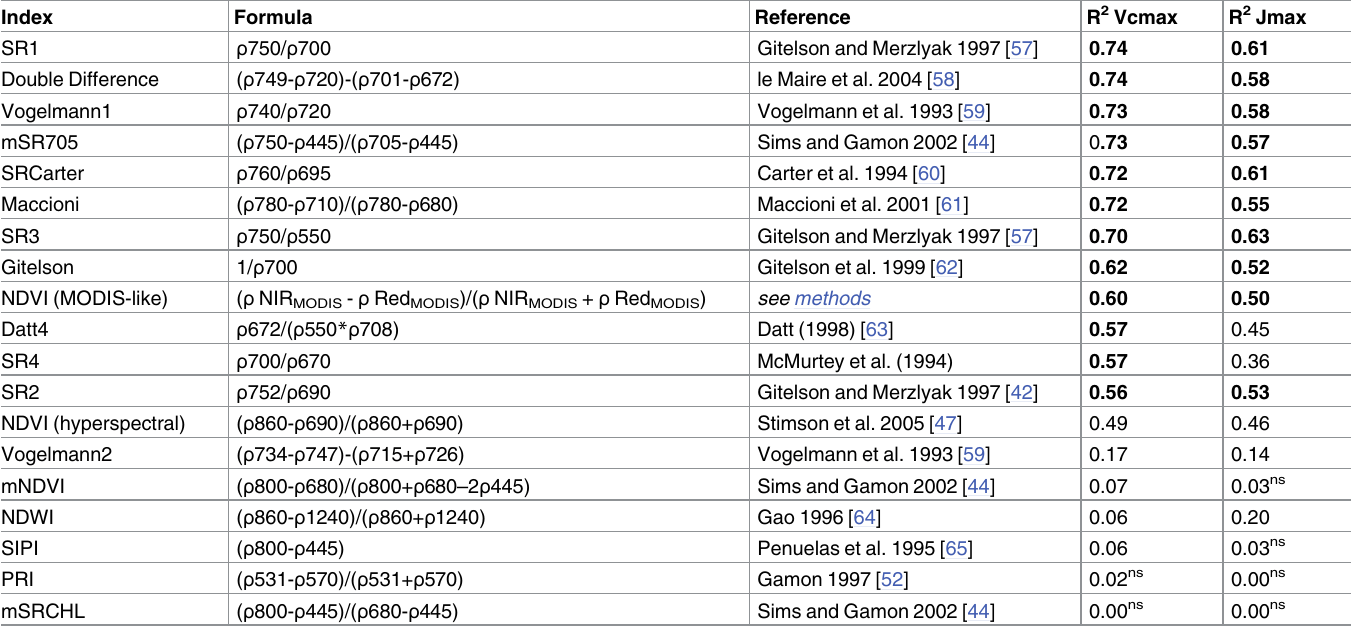
Table 1. Hyperspectral vegetation indices that were compared to estimated V cmax and J max values.